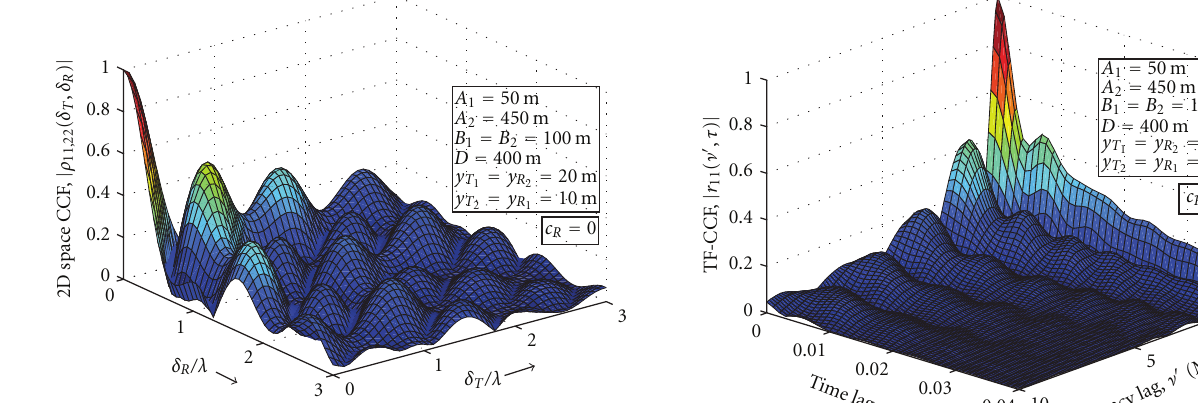
Figure 3: Absolute value of the 2D space CCF | ρ 11,22 ( δ T , δ R ) | of the reference model for a NLOS propagation scenario ( c R = 0).